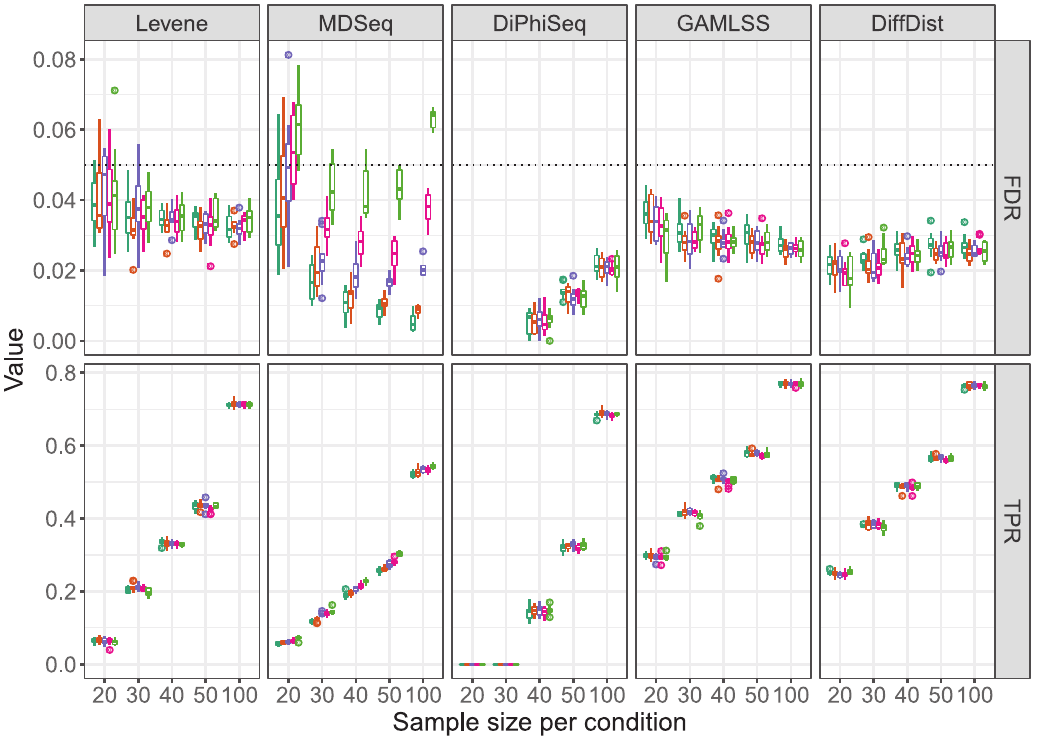
Fig 2. Ability to detect differential dispersion for lowly differentially expressed genes. False discovery rate (FDR) and true positive rate (TPR) of Levene’s test, MDSeq, DiPhiSeq, GAMLSS and DiffDist for differential dispersion detection in simulated datasets composed of lowly differentially expressed genes between two sample populations of equal size. The performances were assessed using 10 replicates of simulated datasets per parameter setting.